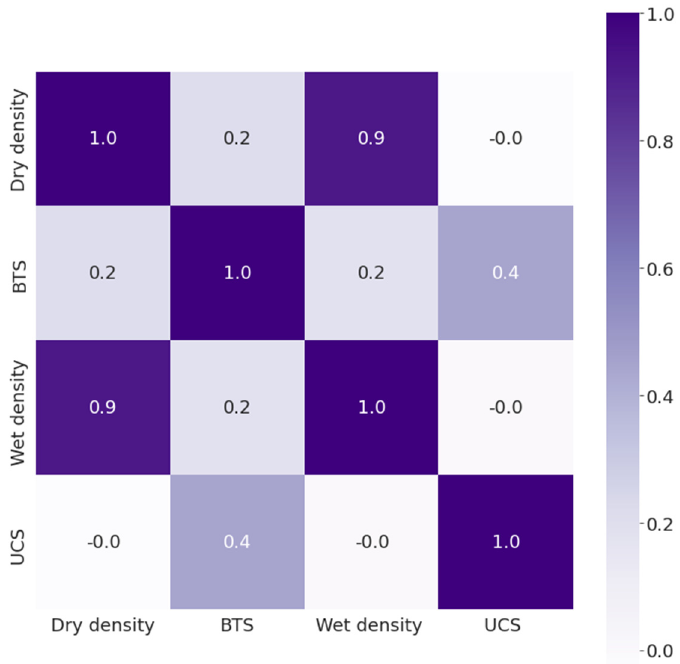
Figure 4. Correlation plot of inputs (dry density (g/cm 3 ), BTS (MPa), and wet density (g/cm 3 )) and output (UCS (MPa)) of the original dataset in this study. Table 2. Physical and mechanical parameters of the dataset.